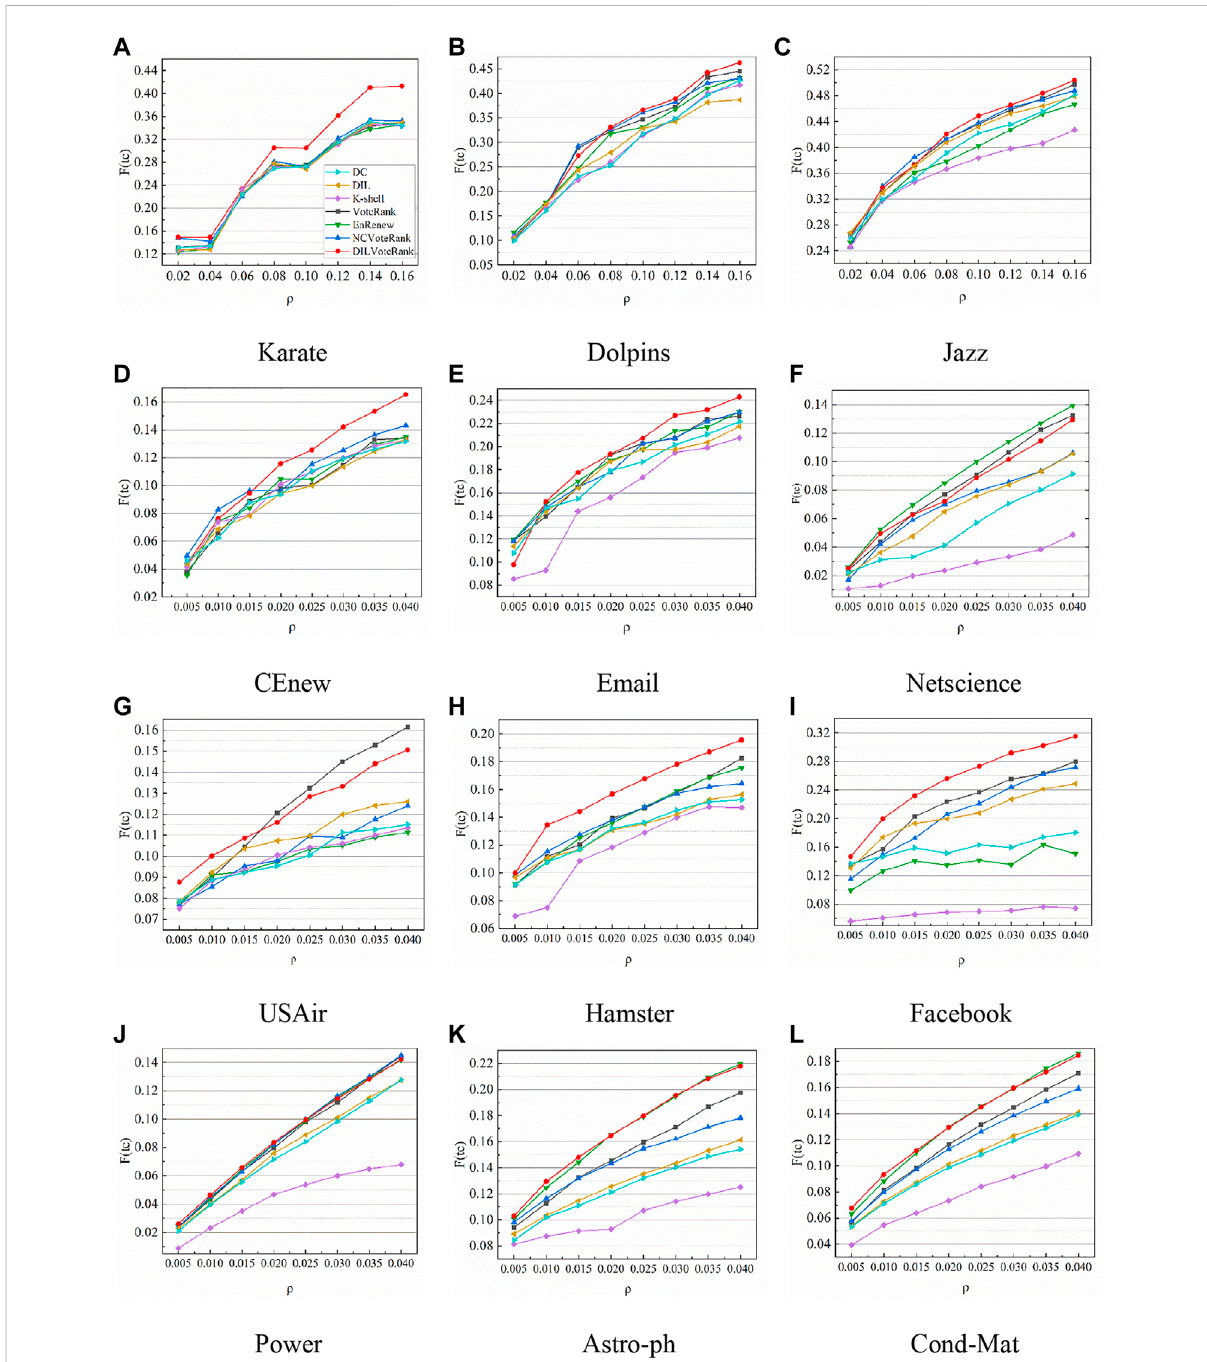
FIGURE 3 The variation curve of the fi nal infection scale with the initial infected node ratio, the results of this experiment take the average of 1,000 calculations, set the infected rate ζ (cid:2) 1 . 25. Subgraphs (A – L) respectively represent the experimental results of 12 datasets in Table